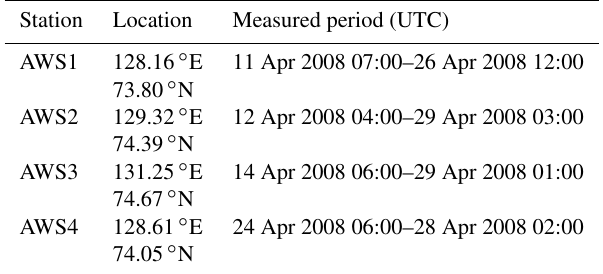
Table 2. Overview of the four automatic weather stations (AWS) with hourly measurements which were deployed during the Trans- drift XIII-2 expedition from 11 to 29 April 2008 (Heinemann et al., 2010). See the location of the AWS in Fig.